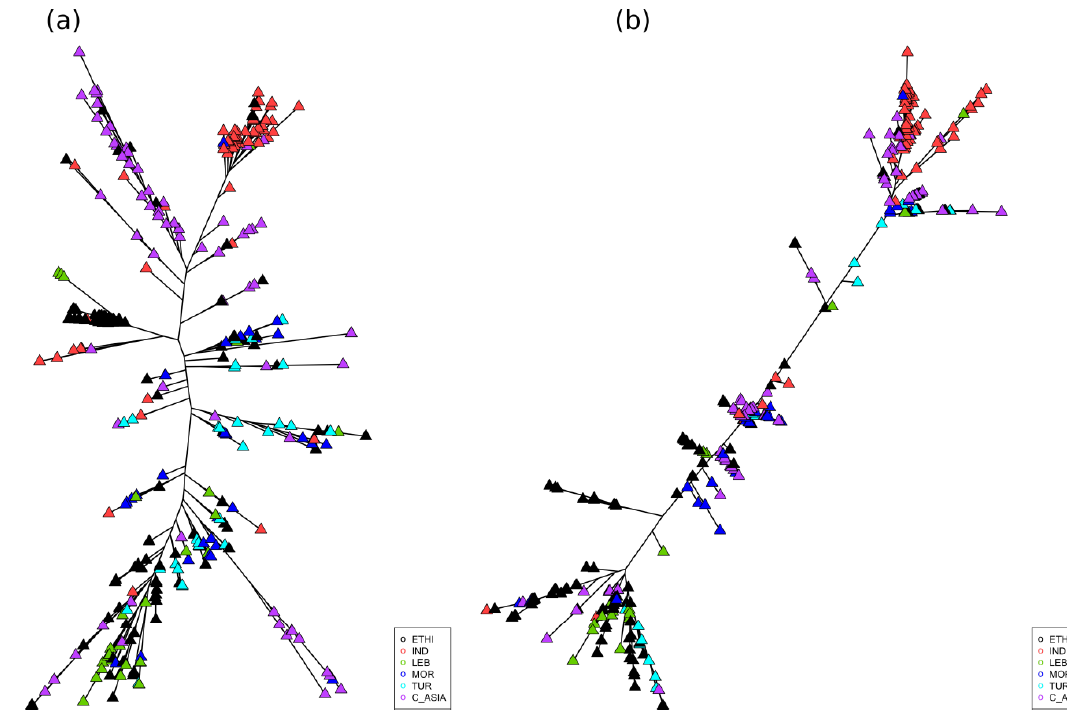
Figure 5. ( a ) Maximum likelihood phylogenetic tree showing relationships among accessions based the whole genome SNPs and ( b ) on chromosome 4 on the whole genome SNPs and ( b ) on chromosome 4 SNPs.